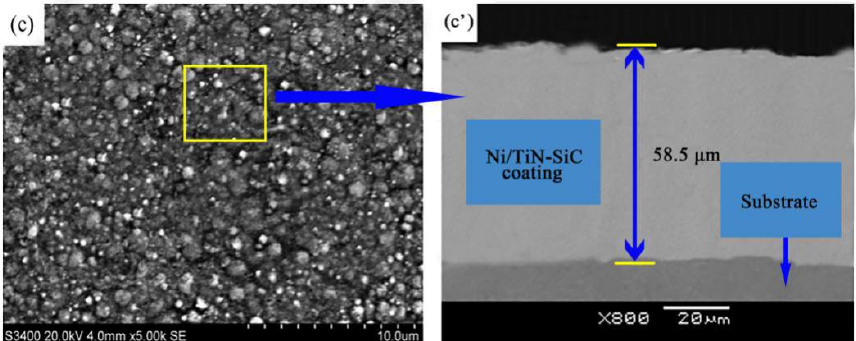
Figure 3. SEM micrographs of Ni/TiN-SiC nanocomposites fabricated by employing various pulse current densities: ( a ) and ( a’ ) 2 A/dm 2 , ( b ) and ( b’ ) 4 A/dm 2 , and ( c ) and ( c’ ) 6 A/dm 2 .